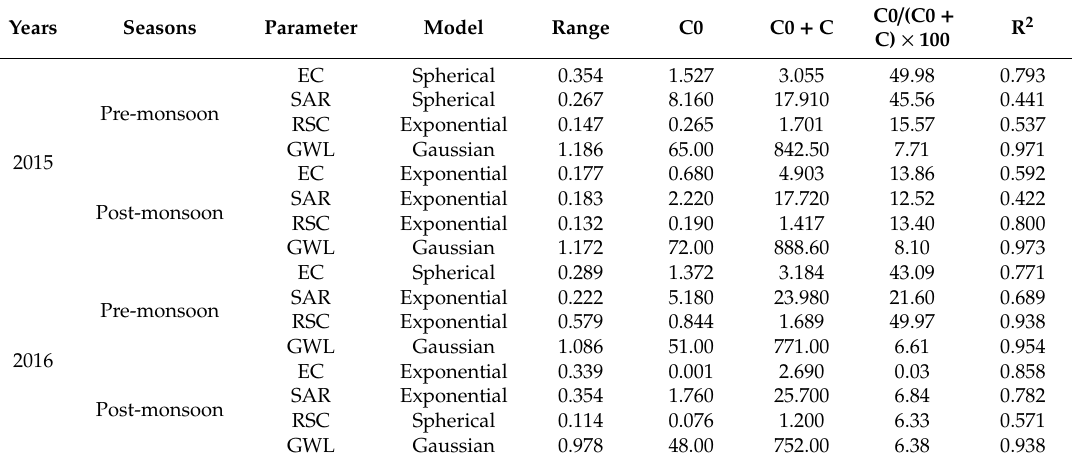
Table 5. Fitted semi-variogram model of groundwater properties in 2015 and